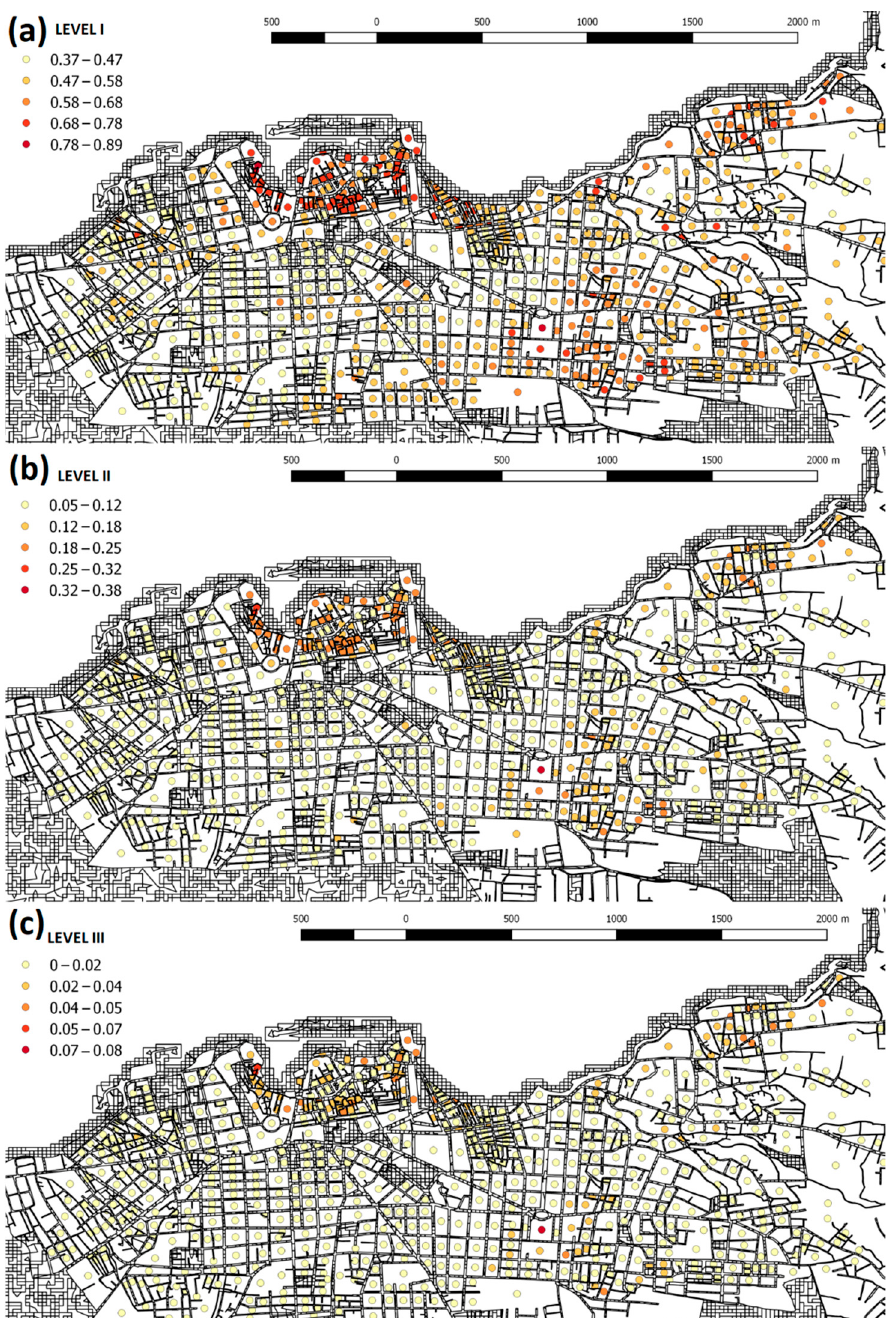
Figure 5. Likelihood of earthquake-related impact per building block in the city of Chania for ( a ) level I, ( b ) level II, and ( c ) level III. Table 1. Earthquake-related impact level description, modified by Mota de Sá et al. [24].. Impact Level